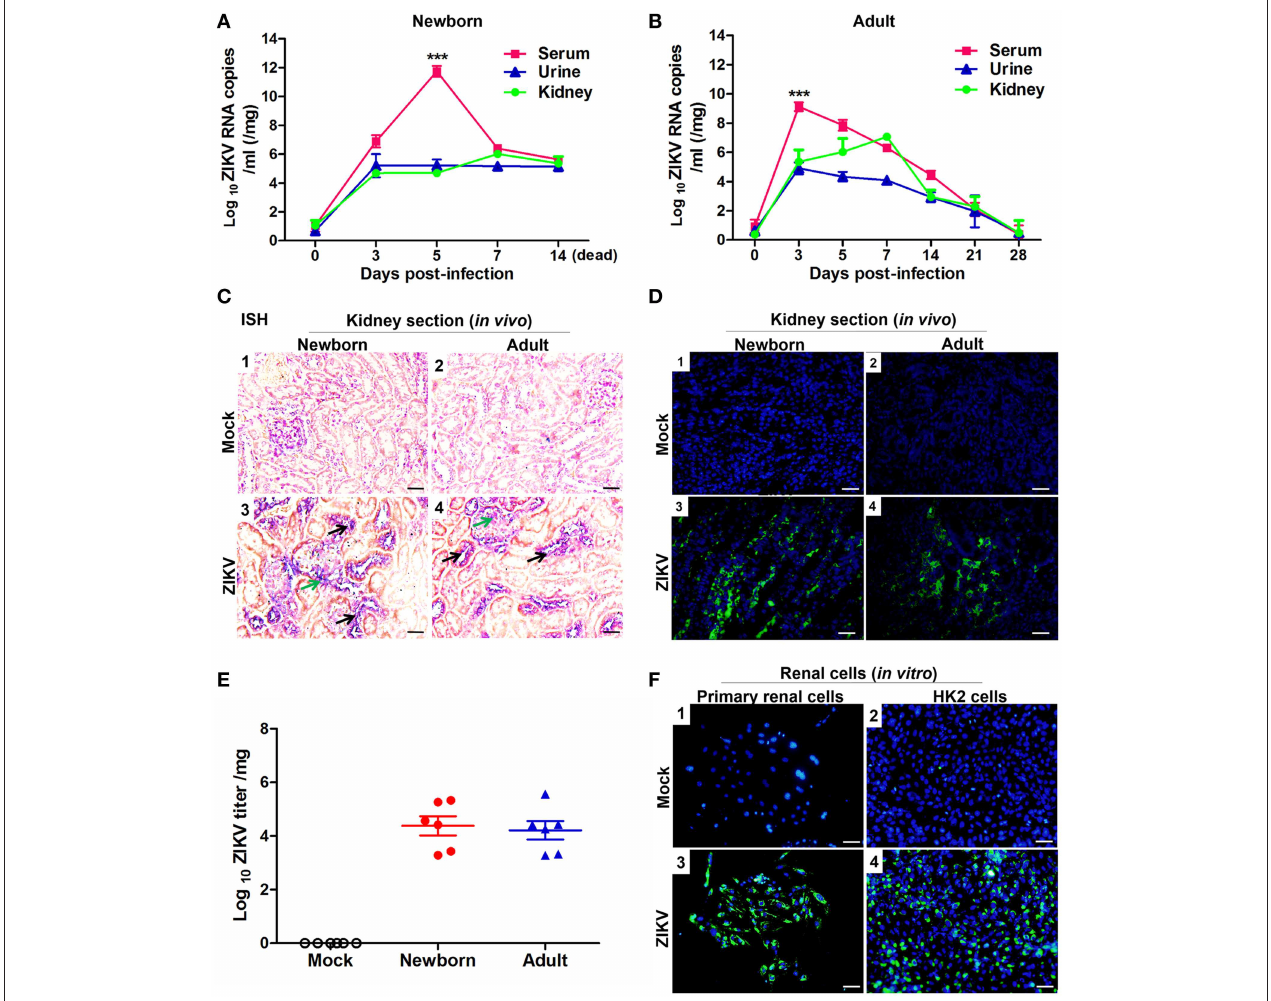
FIGURE 1 | ZIKV infection in the kidneys of mice and in vitro renal cells. (A,B) Newborn (A) and adult (B) mice viral loads were measured by qRT-PCR in the serum, urine, and kidney at different time points post-infection. (C) Newborn and adult mouse kidney sections were detected with in situ hybridization (ISH) using a ZIKV-specific probe. Hybridization signals of ZIKV RNA were developed by a chromogenic reaction and were observed as blue particles, green and black arrows indicated renal glomerular and tubular cells, respectively. Scale bar 20 µ m. (D) Kidney sections from mock or ZIKV-infected mice were paraffin-embedded and processed, and were stained with antibodies against ZIKV-E protein, ZIKV was detected in green with AlexaFluor ® 488-conjugated secondary antibodies and nuclei was stained with DAPI (in blue). Scale bars, 40 µ m. (E) Plaque assays for viral titers in the kidneys of newborn and adult mice were performed on 7 days post-infection. (F) Mock and ZIKV-infected (MOI = 4) primary renal epithelial cells and human proximal tubular cells (HK-2) cells were cultured for 48h, stained with DAPI to label nuclei (blue) and an antibody against ZIKV E protein (green), examined by confocal microscopy. Scale bars, 40 µ m. Data were presented as mean